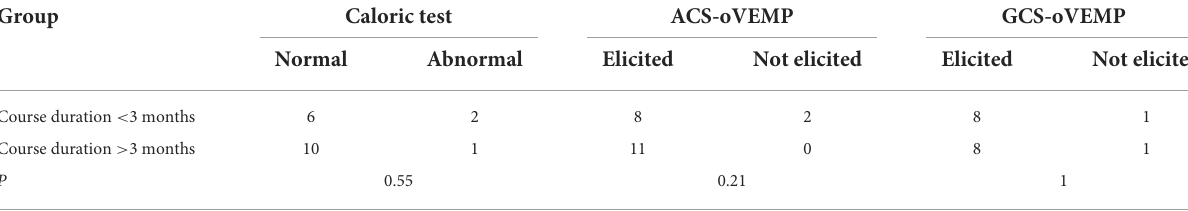
TABLE 4 Comparison of the abnormal rates or the response rates of vestibular testing according to the course duration. Group